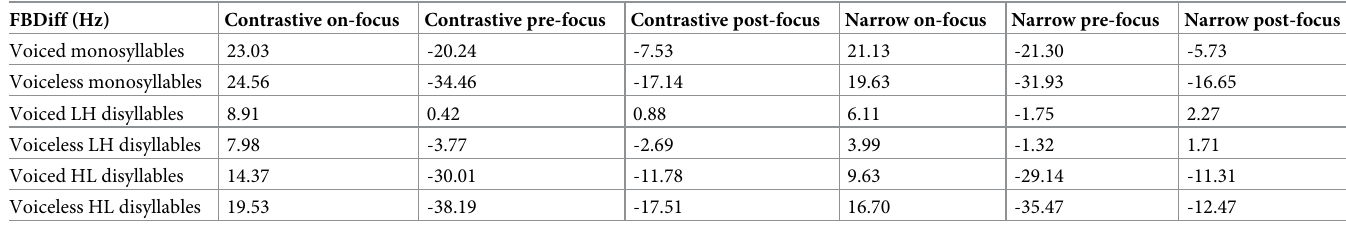
Table 7. Mean f0 perturbation magnitude between baseline and different focus conditions (FBDiff = focus–baseline) of Japanese. Positive sign indicates an increase of f0, compared to the baseline. Negative sign indicates a decrease. FBDiff (Hz) Contrastive on-focus Contrastive pre-focus Contrastive post-focus Narrow on-focus Narrow pre-focus Narrow post-focus Voiced